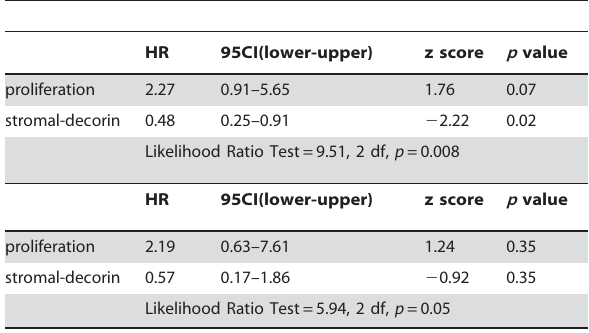
Table 10. Cox proportional hazards models for UPPSALA estrogen receptor-negative older ( . 60) and younger ( , 60) women.